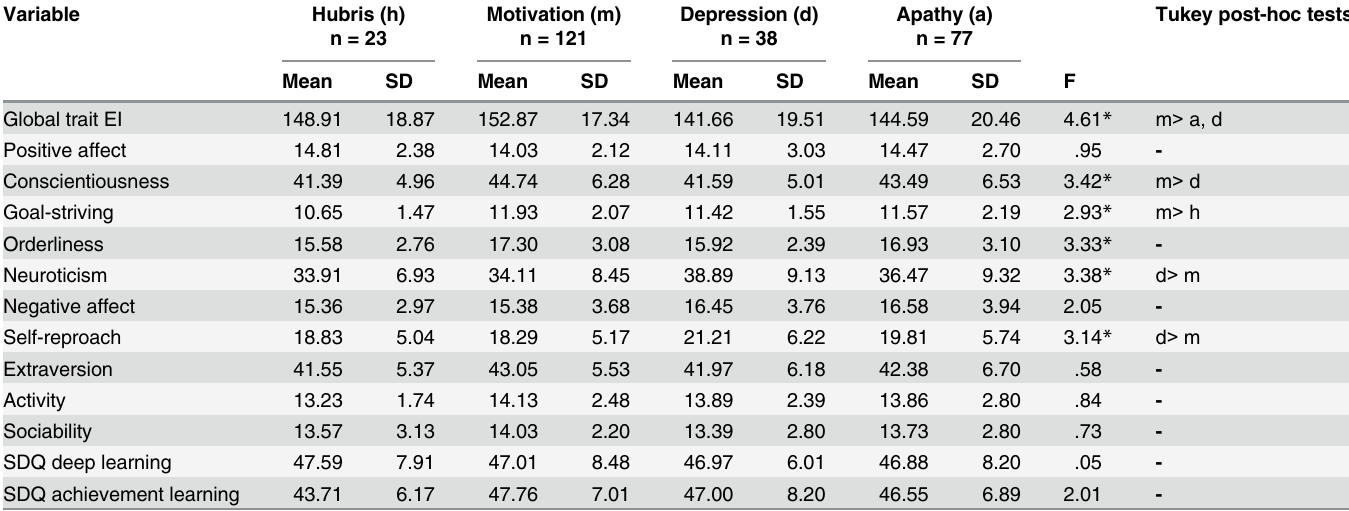
Table 2. Descriptive Statistics and One-Way ANOVA Results for the Family Classification. Variable